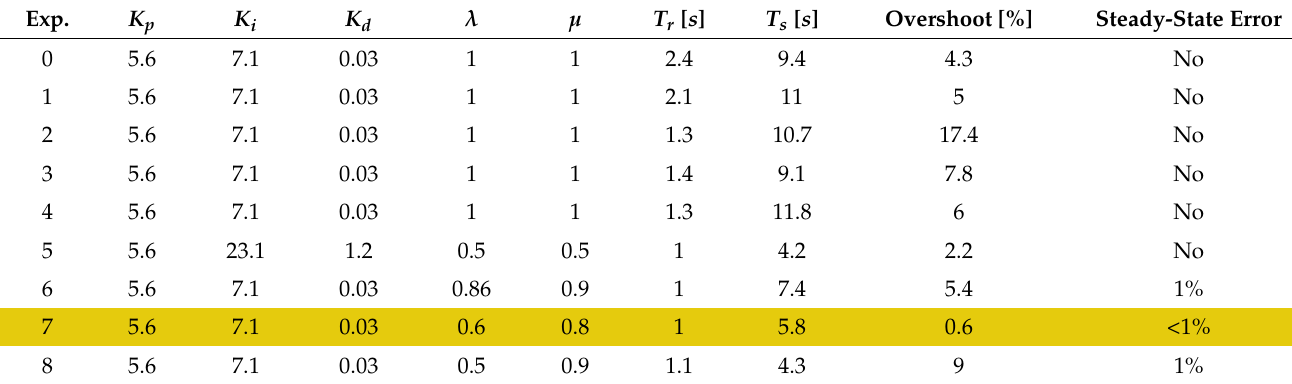
Figure 12. Comparison of the step responses of ( a ) the PID (0–4) and PI λ D µ (5–8) control of a real DEA and comparison of step responses of ( b ) the PID and PI λ D µ control in different domains. Table 5. Comparison of the step responses of the PID (0–4) and PI λ D µ (5–8) control of a real DEA. Exp.